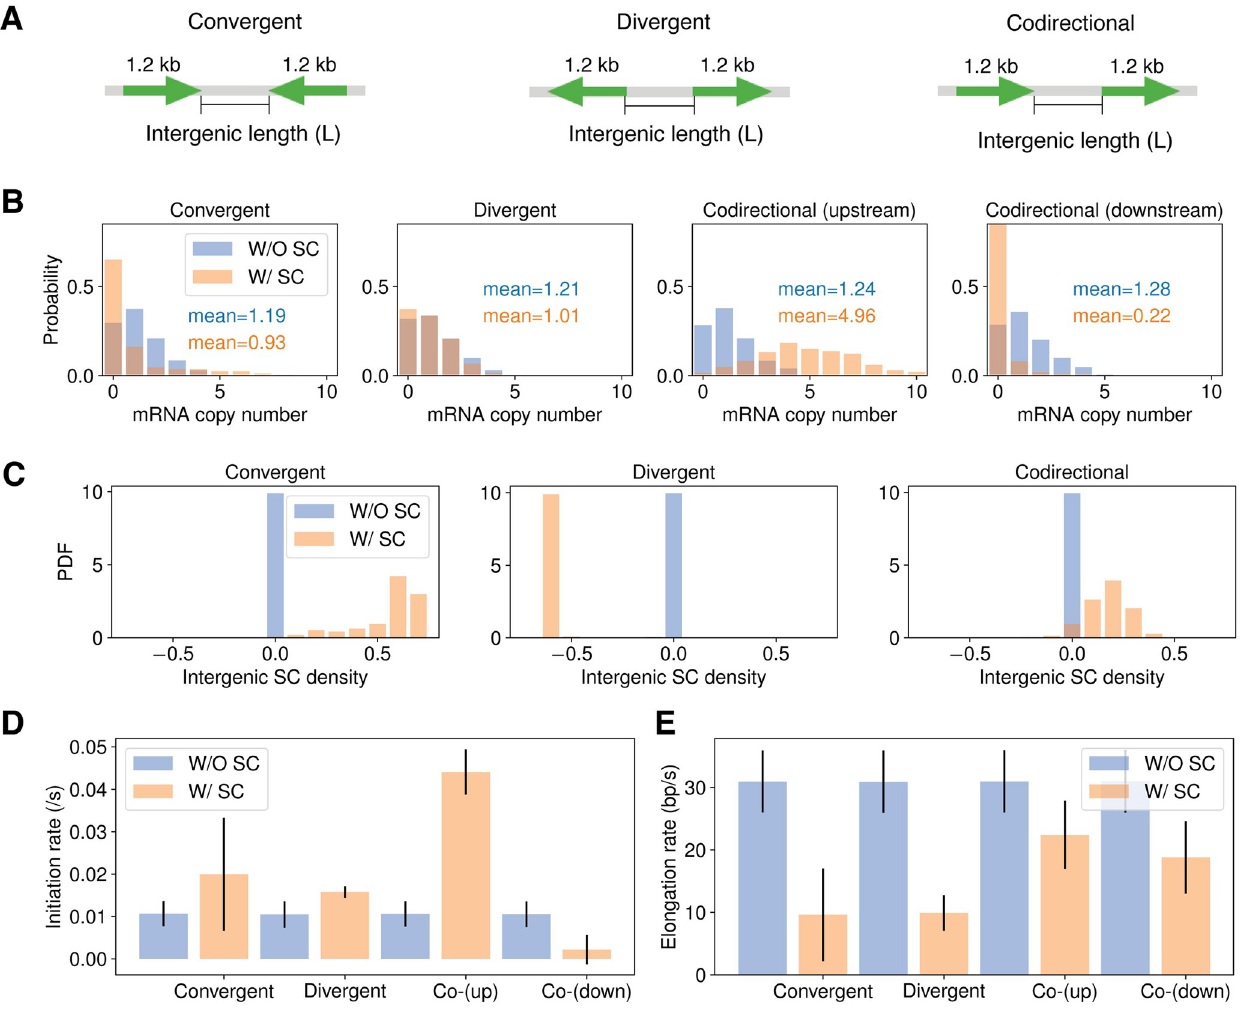
Fig 5. Intergenic supercoiling affects the level of mRNA production of two neighboring genes. (A) The construct for convergently, divergently and codirectionally arranged genes with the intergenic length fixed at 1.2 kb. The mRNA copy number distribution (B) and intergenic supercoiling distribution (C) for cases with (orange bar) and without (blue bar) intergenic supercoiling. The bar plot for initiation rate (D) and elongation rate (E) for cases with (orange bar) and without (blue bar) intergenic supercoiling. Error bar suggests standard